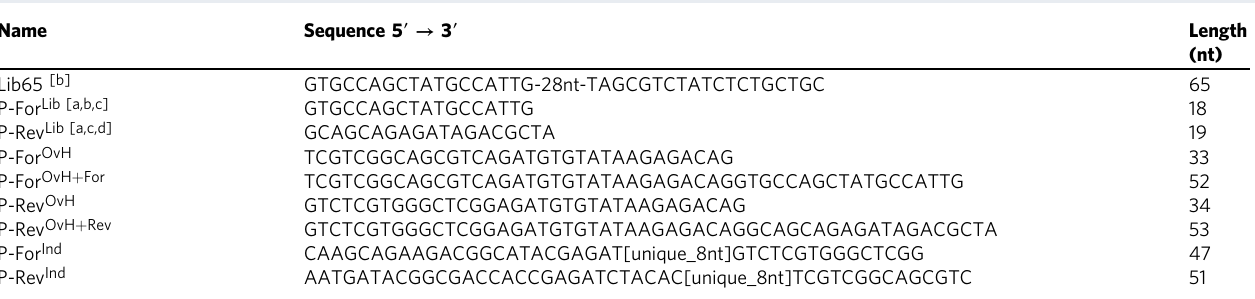
Table 1 List of oligonucleotides used in the selection and characterisation of aptamers with binding af fi nity to